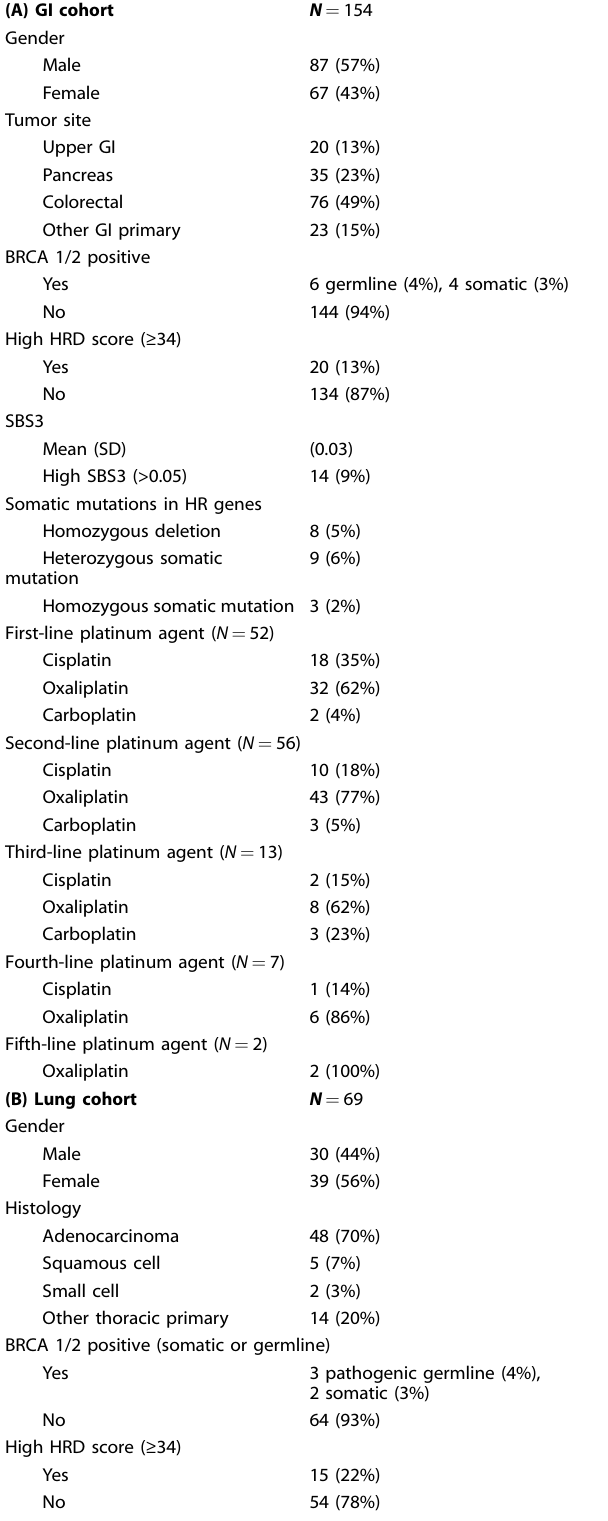
Table 1. (A) Baseline characteristics and HRD/SBS3 status of patients with advanced gastrointestinal malignancies. (B) Baseline characteristics and HRD/SBS3 status of patients with advanced thoracic